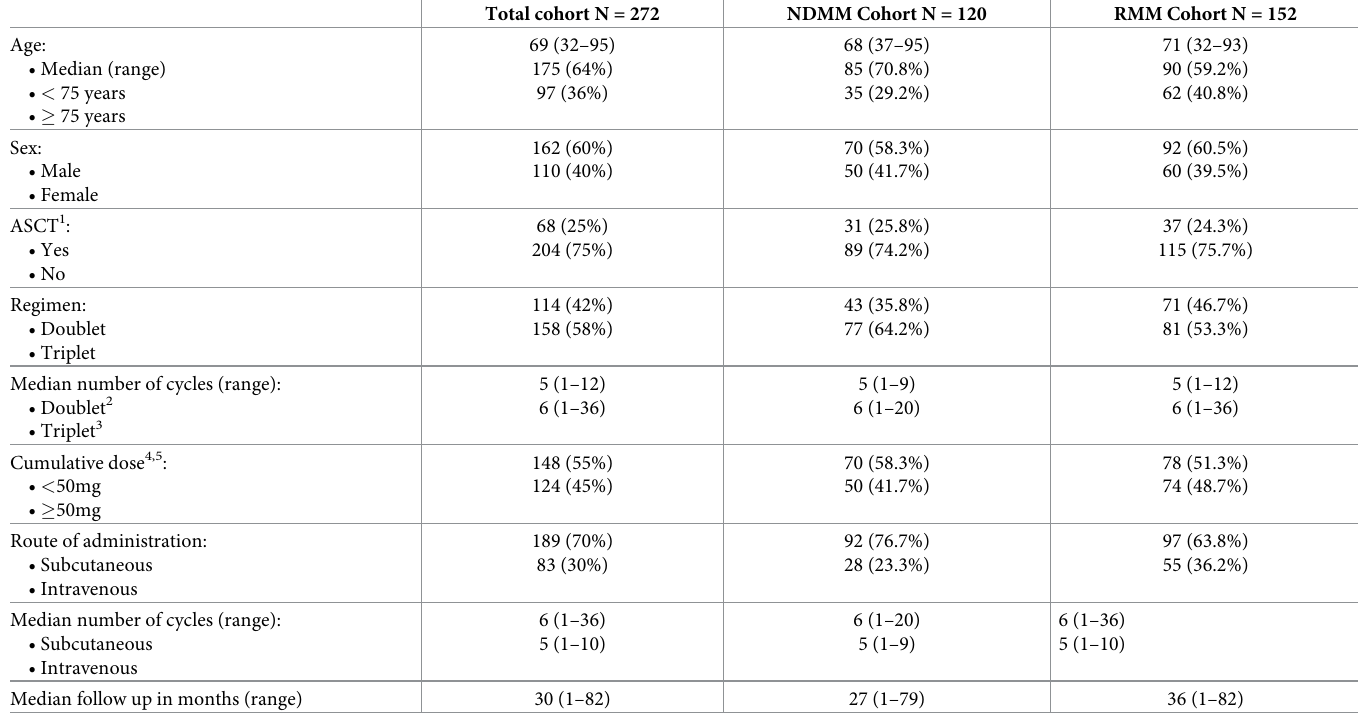
Table 1. Patient and treatment